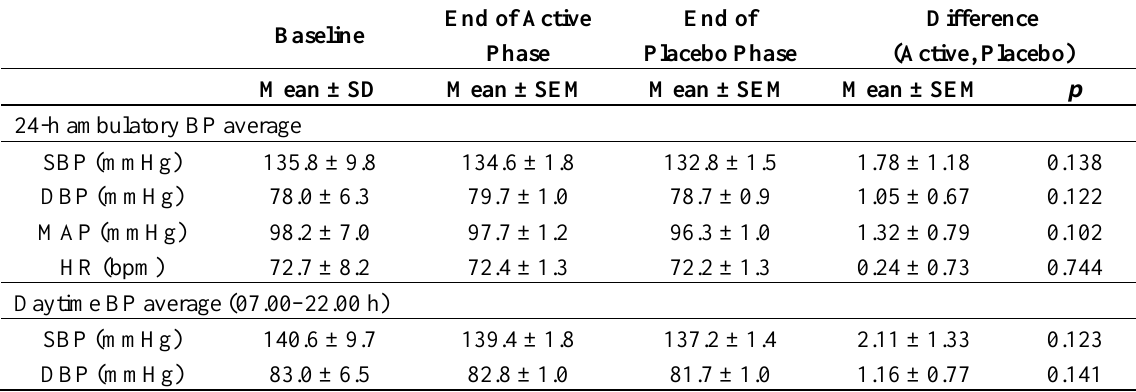
Table 2. Average 24 h, daytime and nocturnal ABP at baseline and the end of each phase ( n =